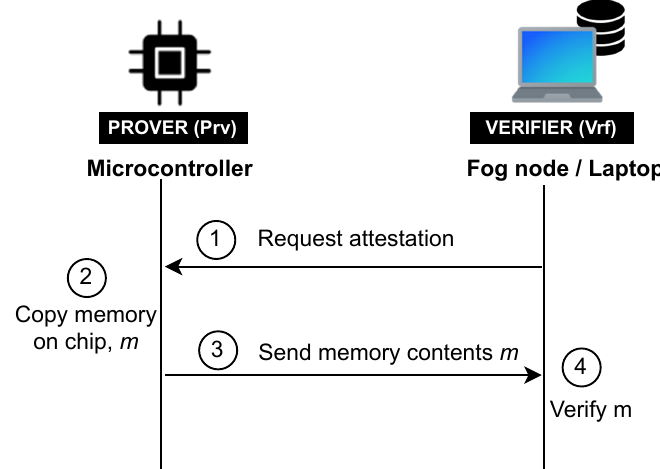
Figure 6. System model of the memory offloading protocol.